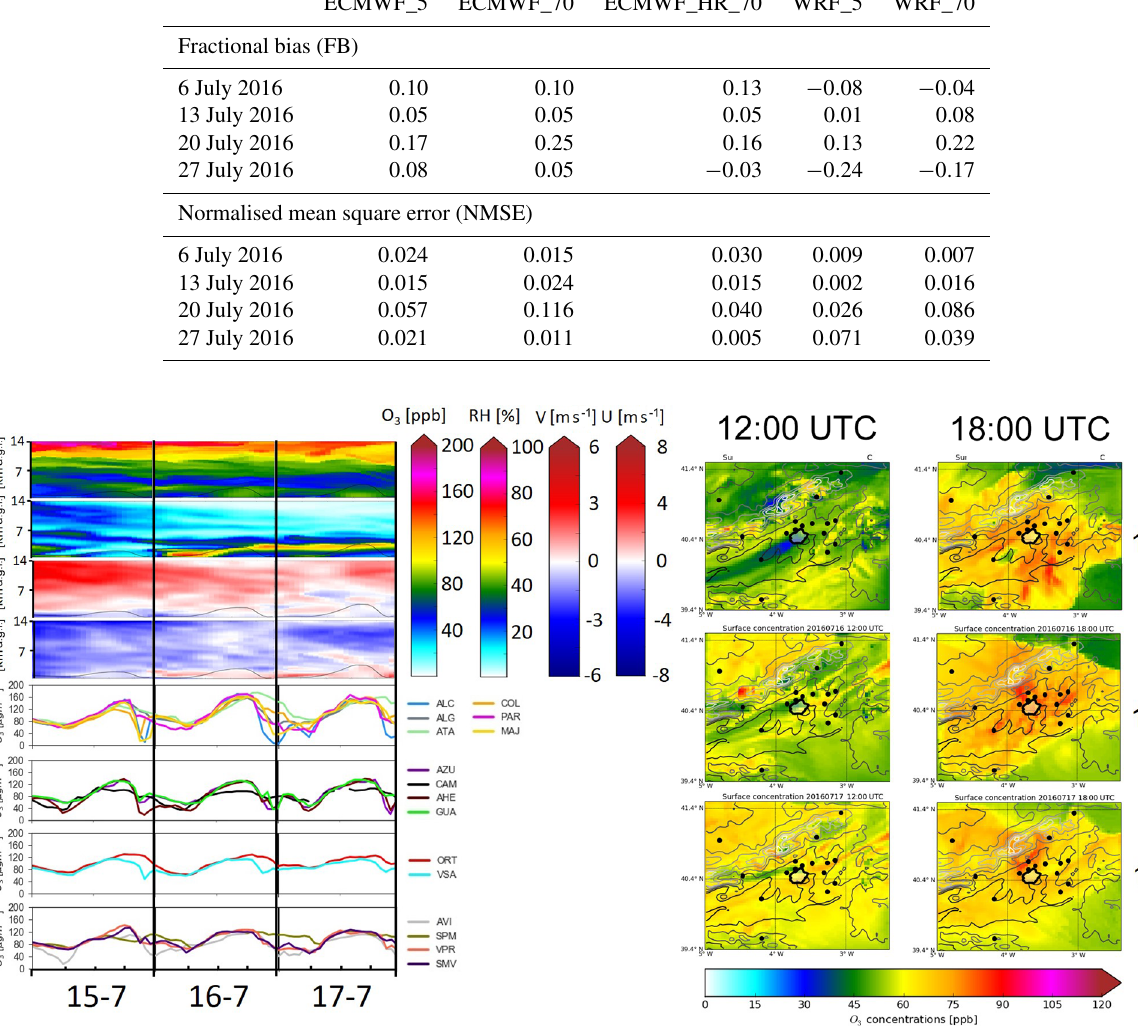
Figure 5. Left: hourly O 3 concentrations recorded at selected monitoring stations in the MAB and simulated fields of O 3 concentration, rela- tive humidity, and U and V components of wind for the period 15–17 July 2016 over the centre of the MAB. Right: surface O 3 concentration maps obtained from LOTOS-EUROS simulations at 12:00 and 18:00UTC of 15, 16 and 17 July 2016. See Fig. 1 to consult the location and typology of the selected